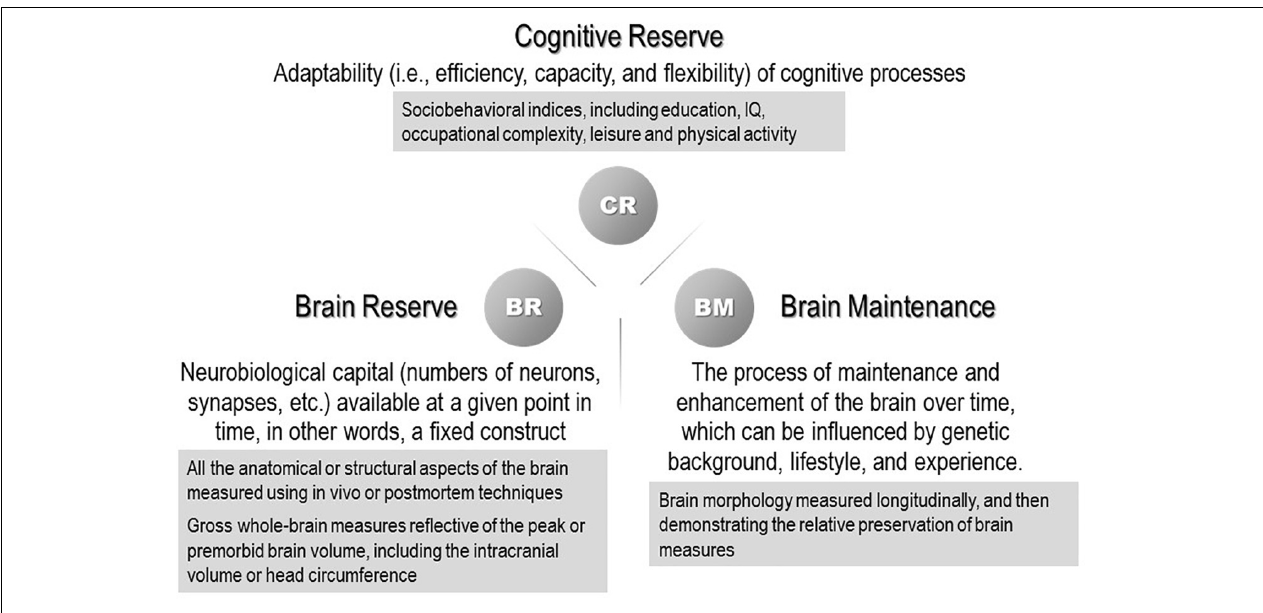
FIGURE 1 | Concepts and definitions of reserve-related terms (Stern et al., 2020). (The proxy measures used in previous studies are shown in the gray